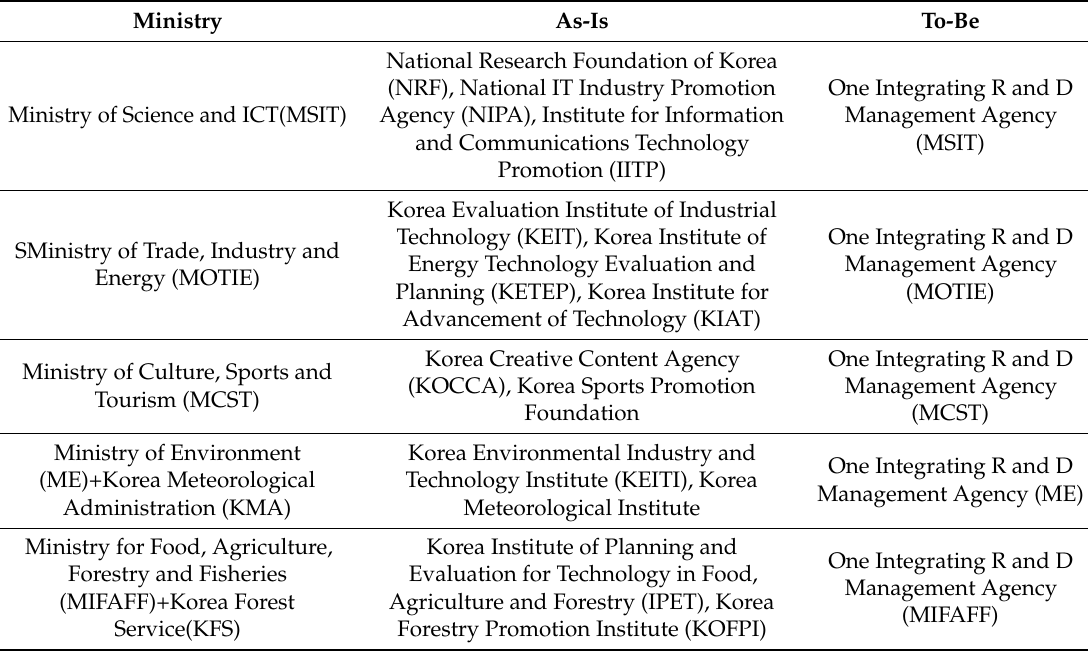
Table 7. Method of integrating R and D management agencies per